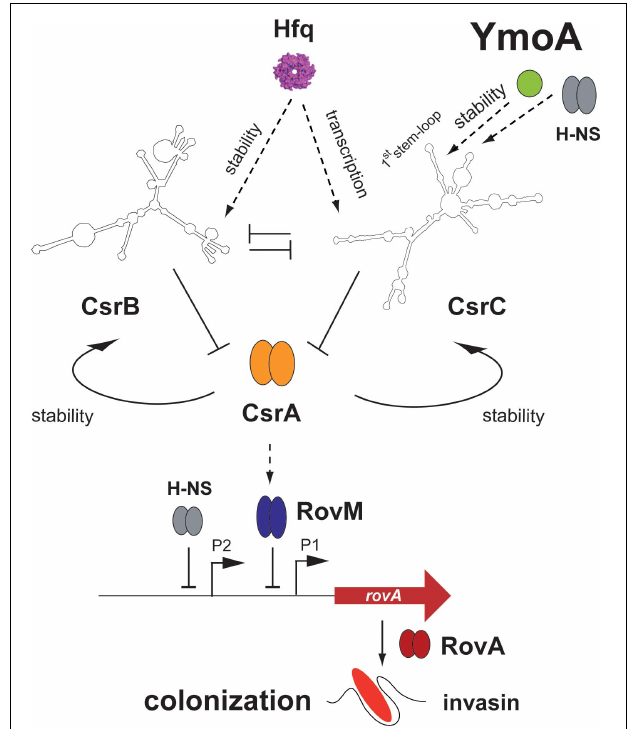
FIGURE 10 | Influence of YmoA on the CsrABC-RovM-RovA-InvA cascade in Y. pseudotuberculosis . YmoA is a global virulence regulator of Y. pseudotuberculosis which is expressed under environmental conditions reflecting the initial stages of infection. It activates the synthesis of early-phase cell internalization factor invasin (InvA) which is important for colonization. This seems to occur together with H-NS, which is known to form heteromeric complexes with YmoA, through regulation of the degradation of the regulatory RNA CsrC at the first stem-loop structure of the CsrC RNA. Influence of YmoA on CsrC occurs independently of Hfq, which was also involved in Csr system control. YmoA and H-NS influence on CsrC is indirect and most likely occurs through RNA-processing factors. As a consequence of YmoA-mediated CsrC upregulation the CsrA-RovM-RovA regulator cascade is activated, leading to expression of colonization factors such as invasin. Dark arrows display direct activation, T represents repression, and dashed arrows indicate (indirect) activation by an unknown molecular